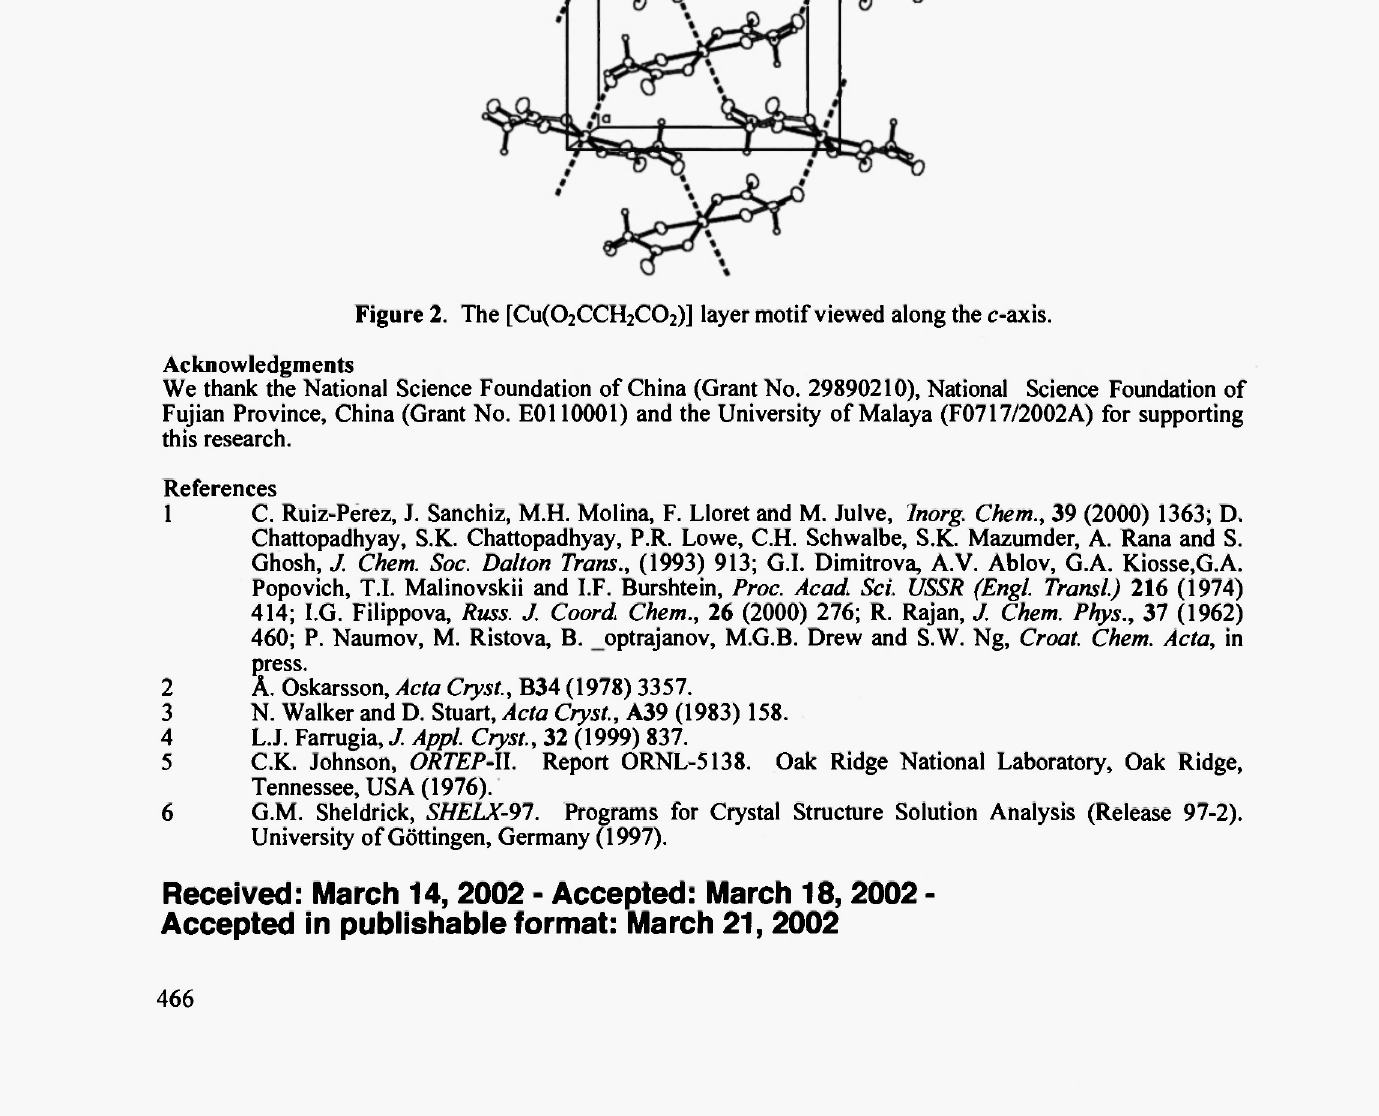
Figure 2. The [Cu(0 2 CCH 2 C02)] layer motif viewed along the